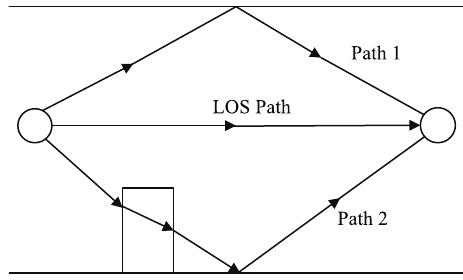
Figure 1. Three signals of the propagation paths.